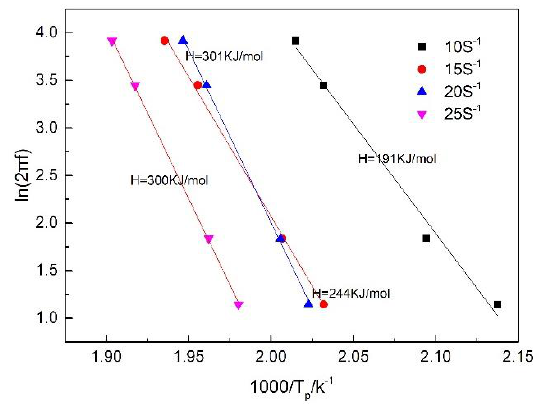
Figure 10. Arrhenius plots of ln(2 π f) and 1000 / Tp for the P1 peaks of rolled ZK60 magnesium alloy under different rates.